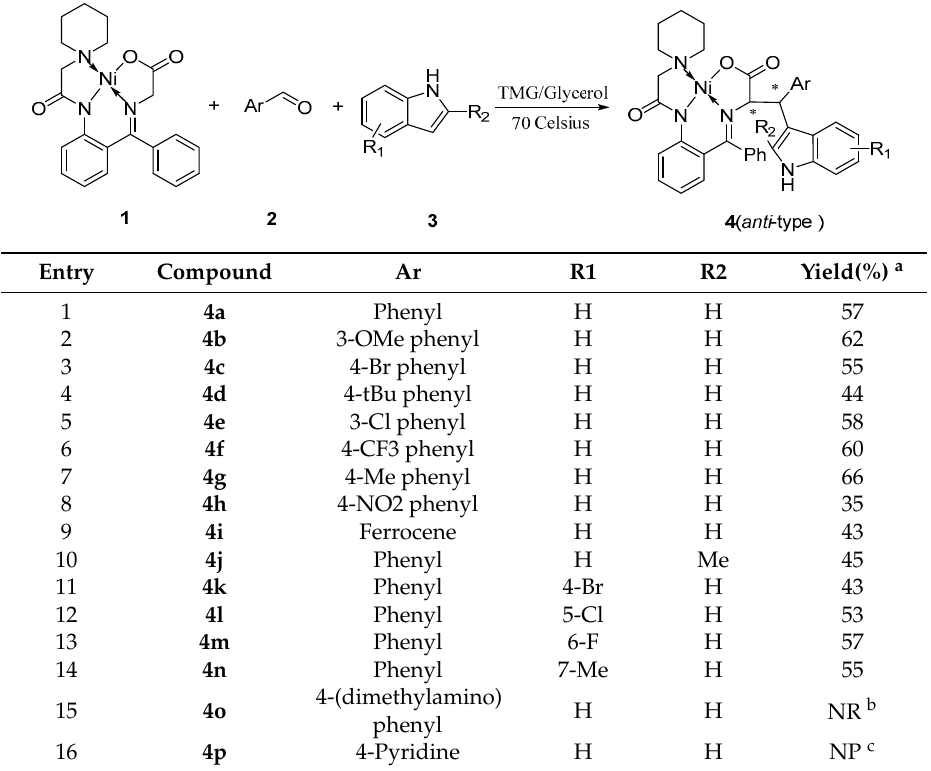
Table 2. Three-component condensation of nickel(II) glycinate, aromatic aldehydes, and indoles.